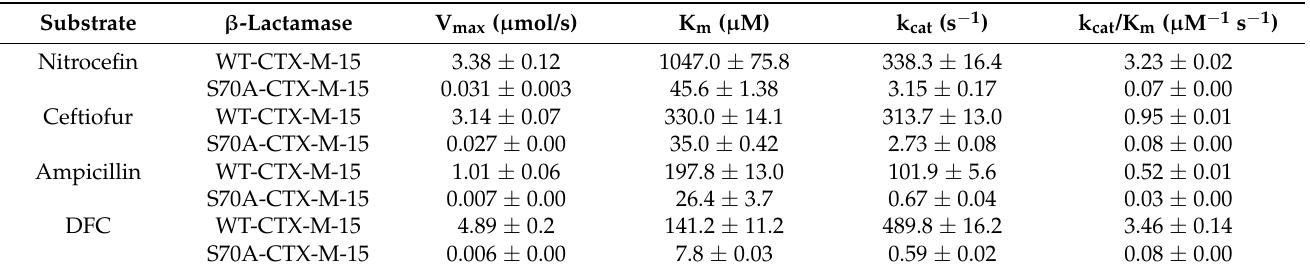
Table 2. Steady-state kinetic parameters for WT-CTX-M-15 and S70A-CTX-M-15 enzymes with corresponding standard deviation (+/ −